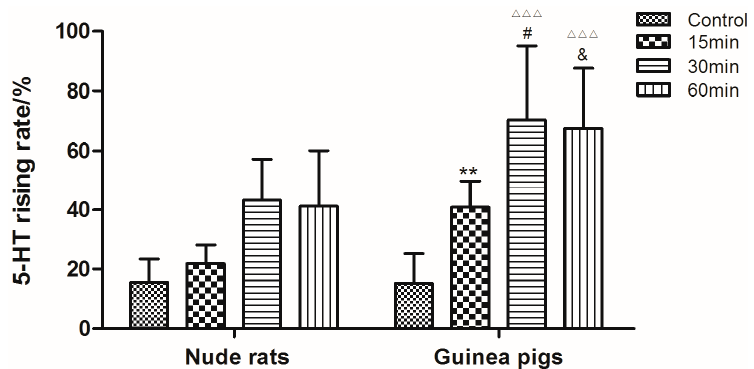
Figure 2. Rising levels of serotonin in guinea pigs ′ and nude rats ′ plasma after treatment with saline and C48/80 for different times (15, 30 and 60 min). ** p < 0.01 vs. Nude rats (15 min); # p < 0.05 vs. Nude rats (30 min); & p < 0.01 vs. Nude rats (60 min); △△△ p < 0.01 vs. Control guinea pigs ( n = 10).